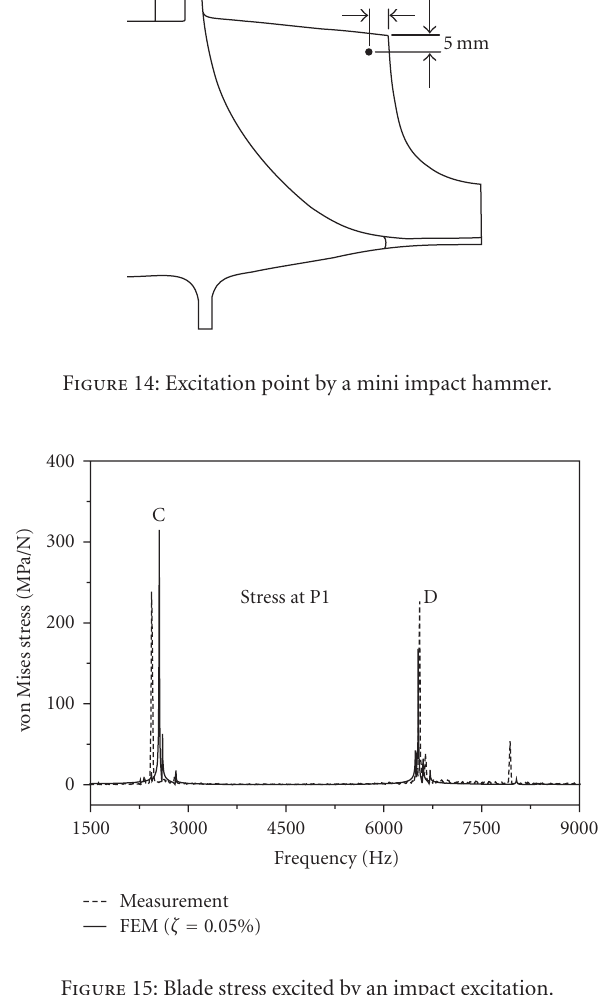
Figure 15: Blade stress excited by an impact